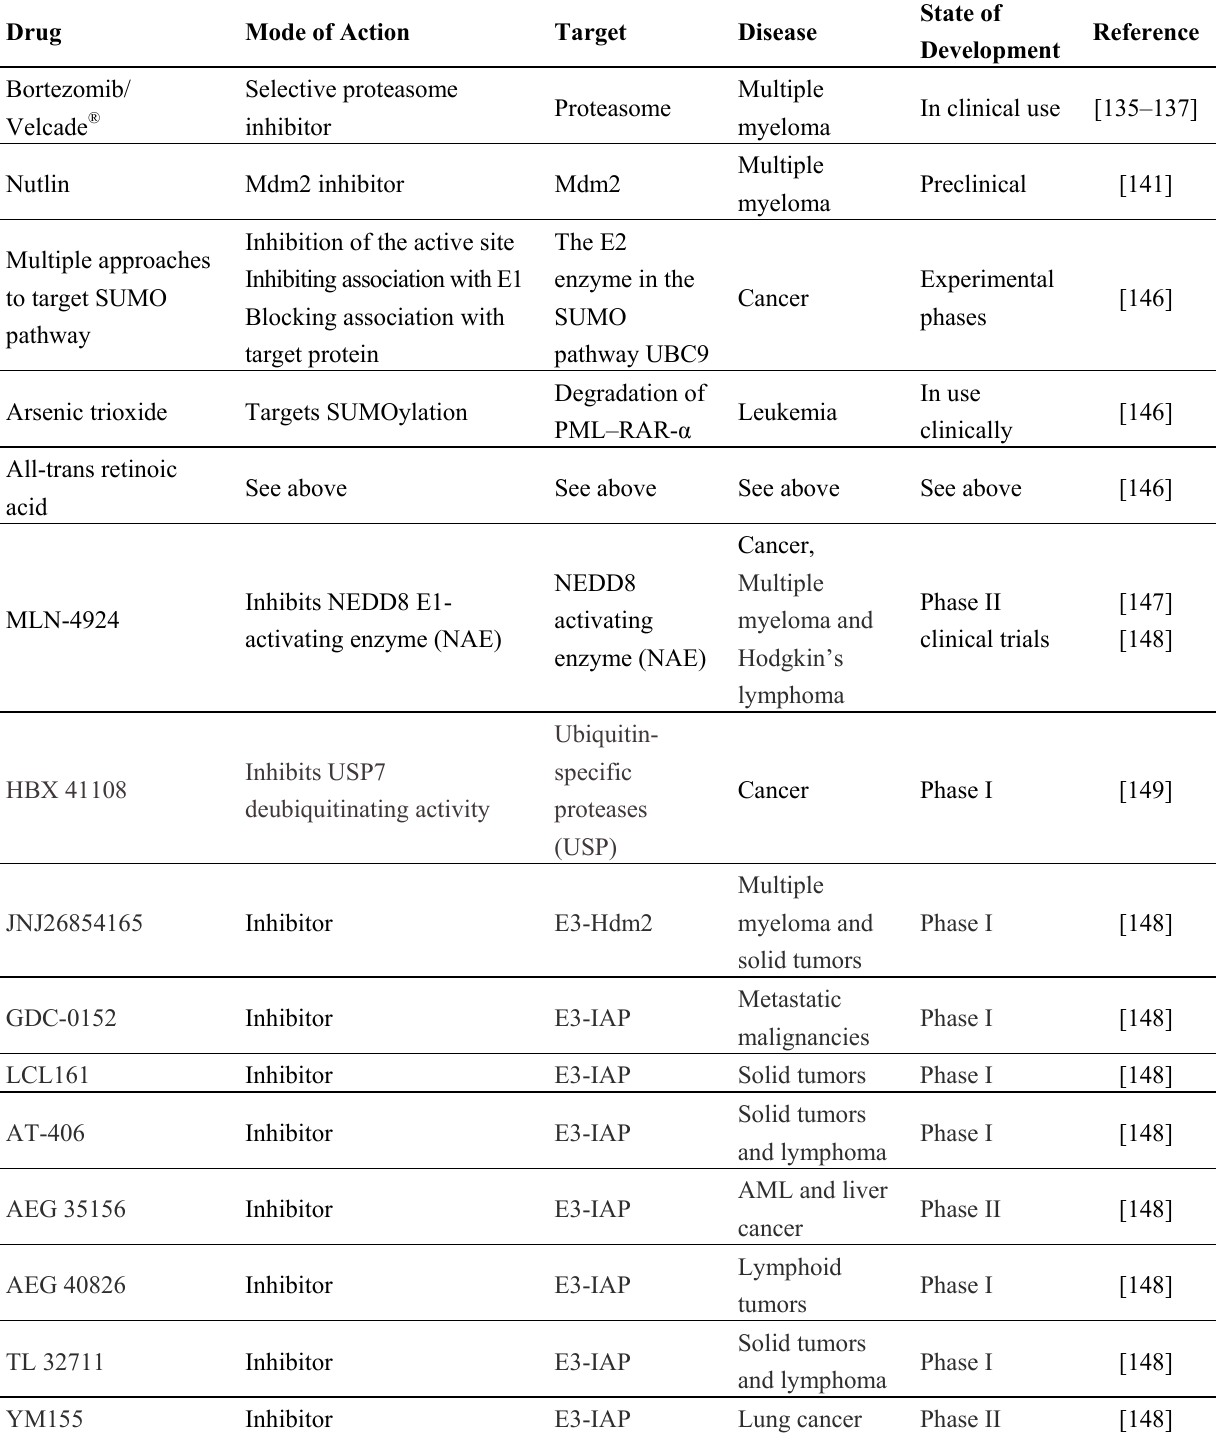
Table 3. Drugs that target the Ubiquitin-proteasome system and